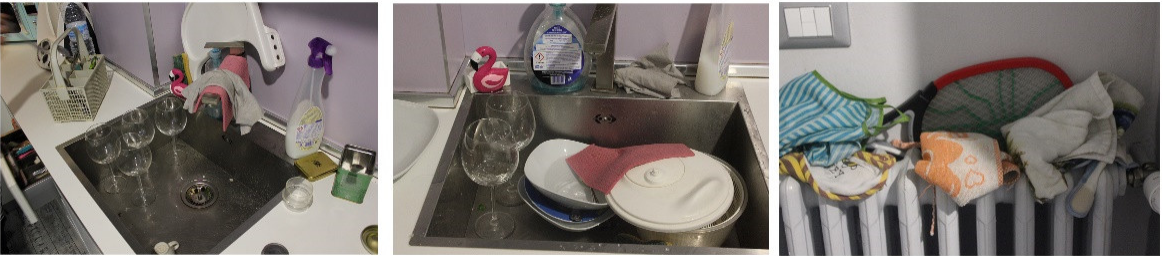
Figure 2. Management of sponges and tea towels.